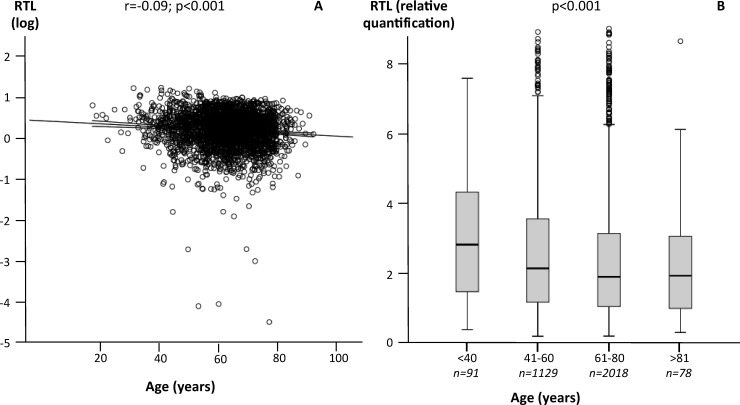
Associations between RTL and age.A) Correlation between RTL (log-transformed) and age. B) RTL according to age strata.